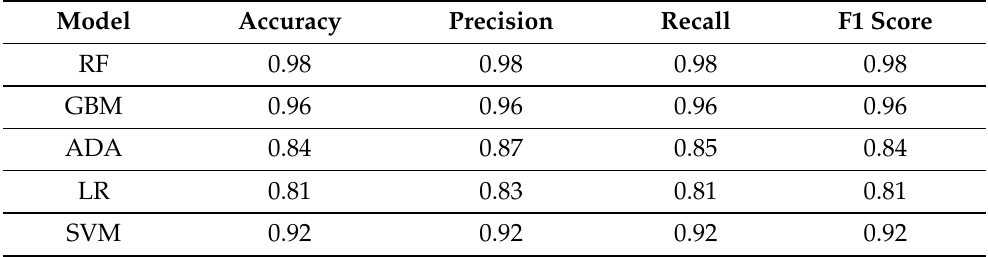
Table 12. Performance of models using BiDFE feature set.